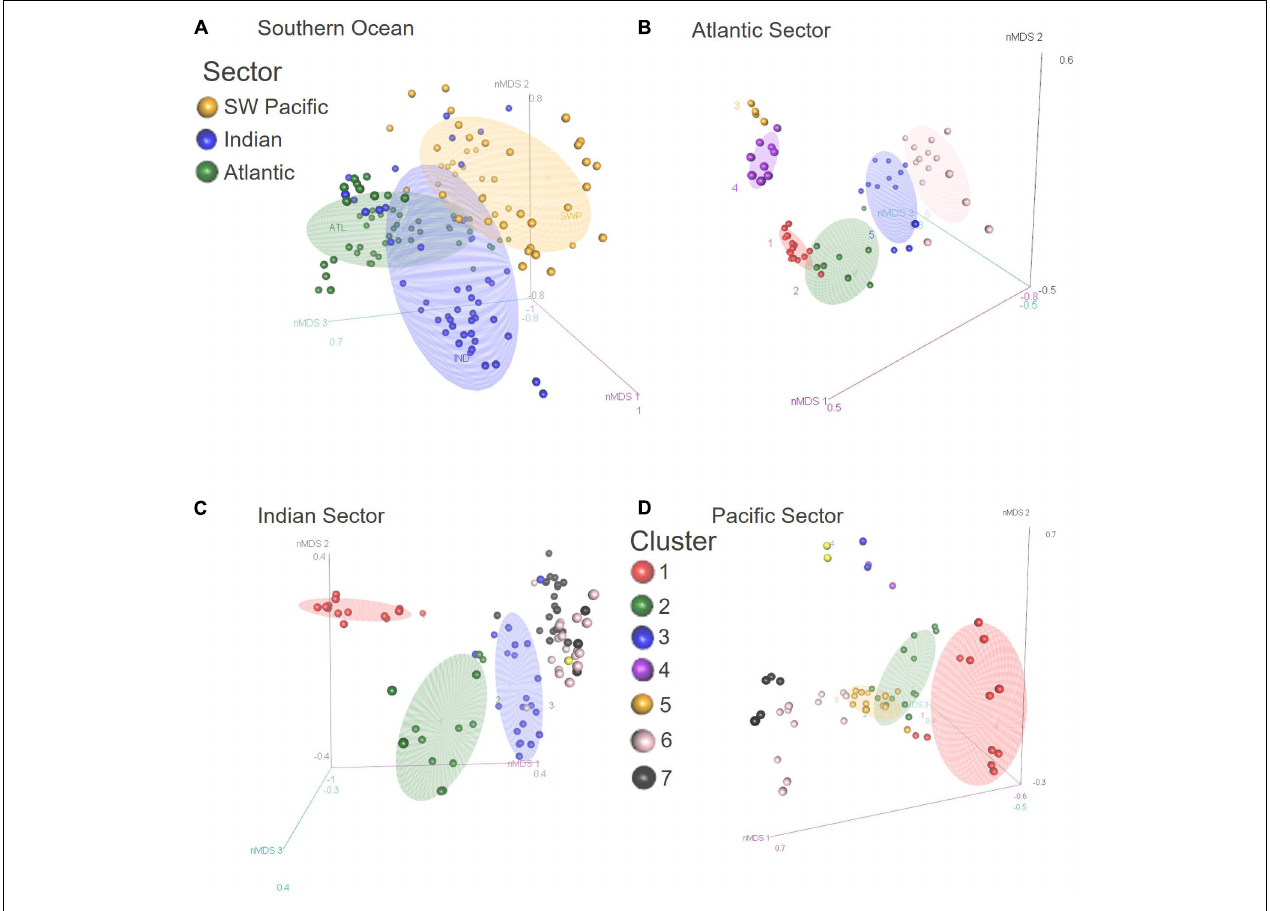
FIGURE 3 | Three dimensional NMDS plots for Hellinger transformed radiolarian assemblage data at sites of the SO-RAD database south of 30 ◦ S for the (A) Southern Ocean, (B) Atlantic, (C) Indian, and (D) Pacific Sectors. Colors represent (A) sectors and (B–D) the ecoregions identified by MRT